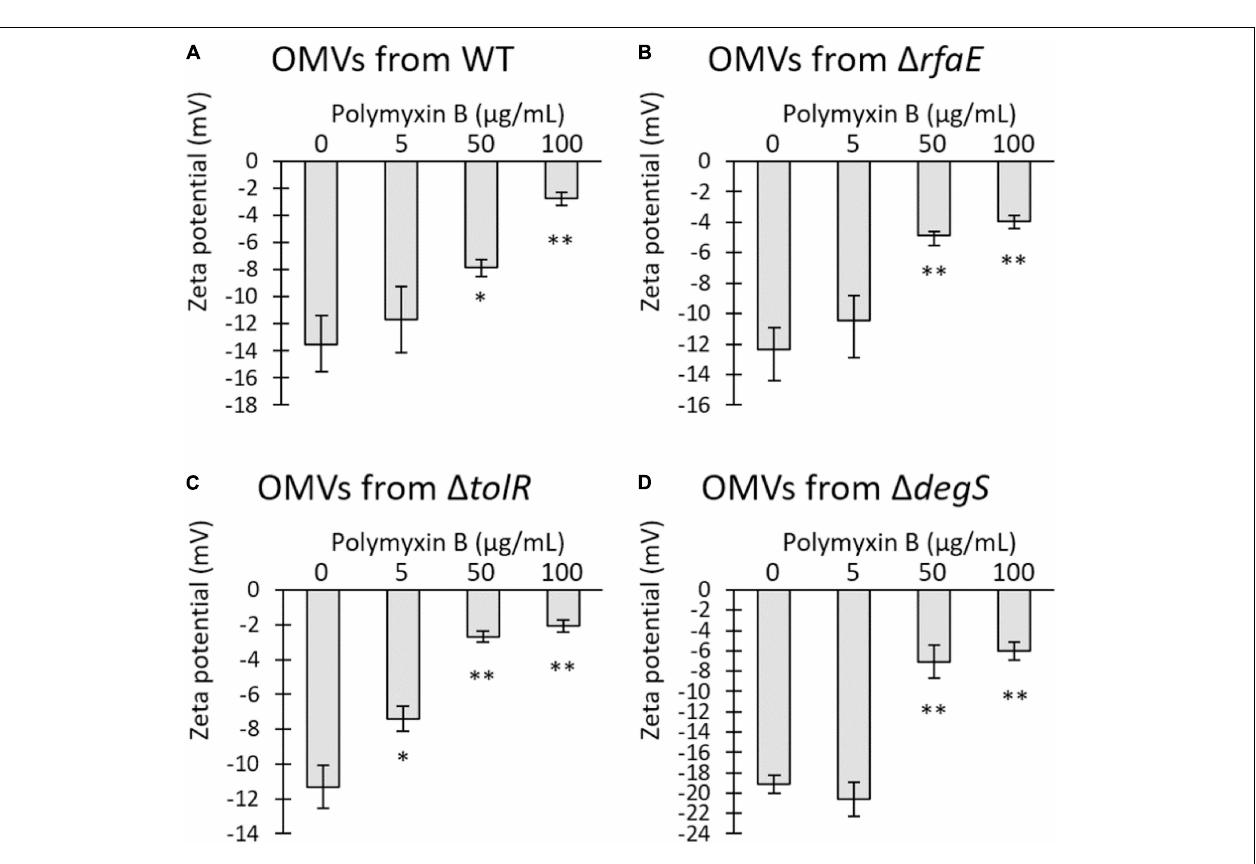
Frontiers in Microbiology |